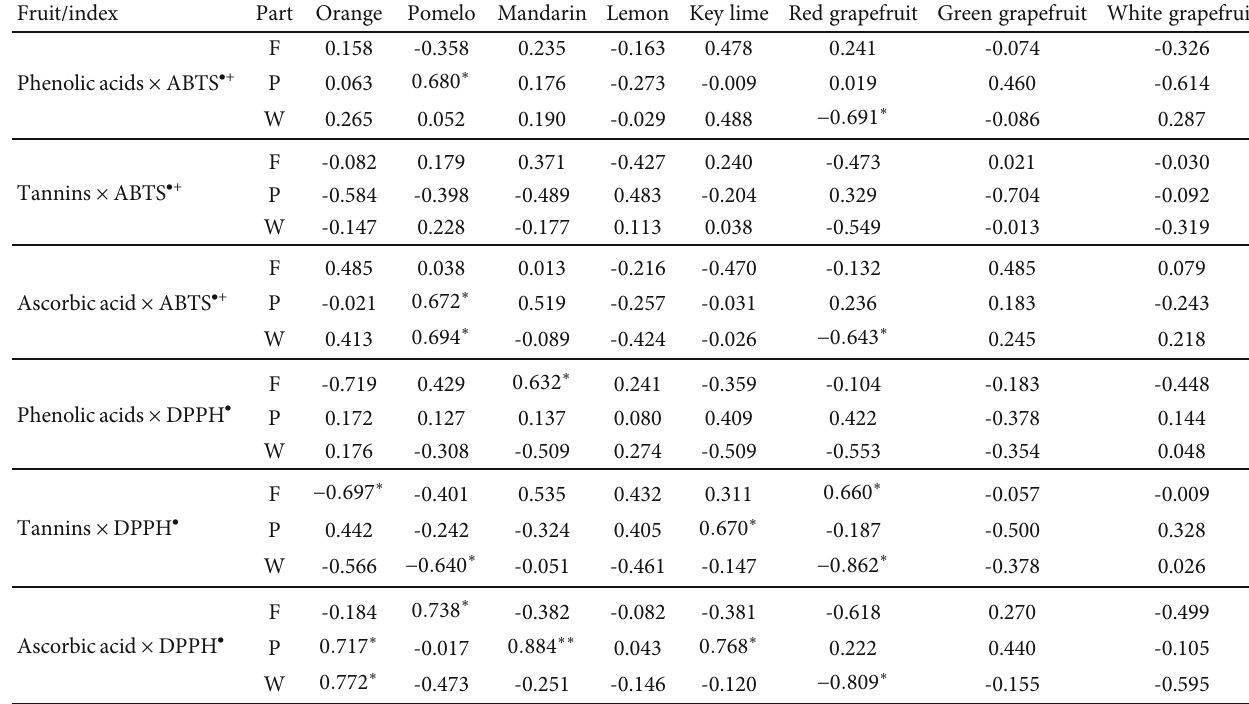
Table 6: Correlation coe ffi cients between ADPH (cid:129) + or DPPH (cid:129) and content of phenolic compounds, ascorbic acid, and tannins for citrus pulp (F), peel (P), and whole fruits (W).